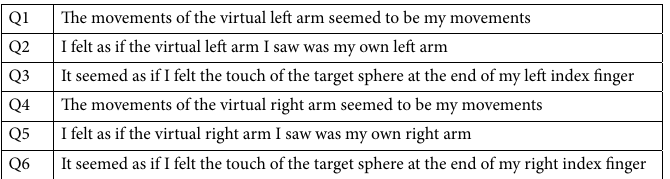
Table 1. Questionnaire